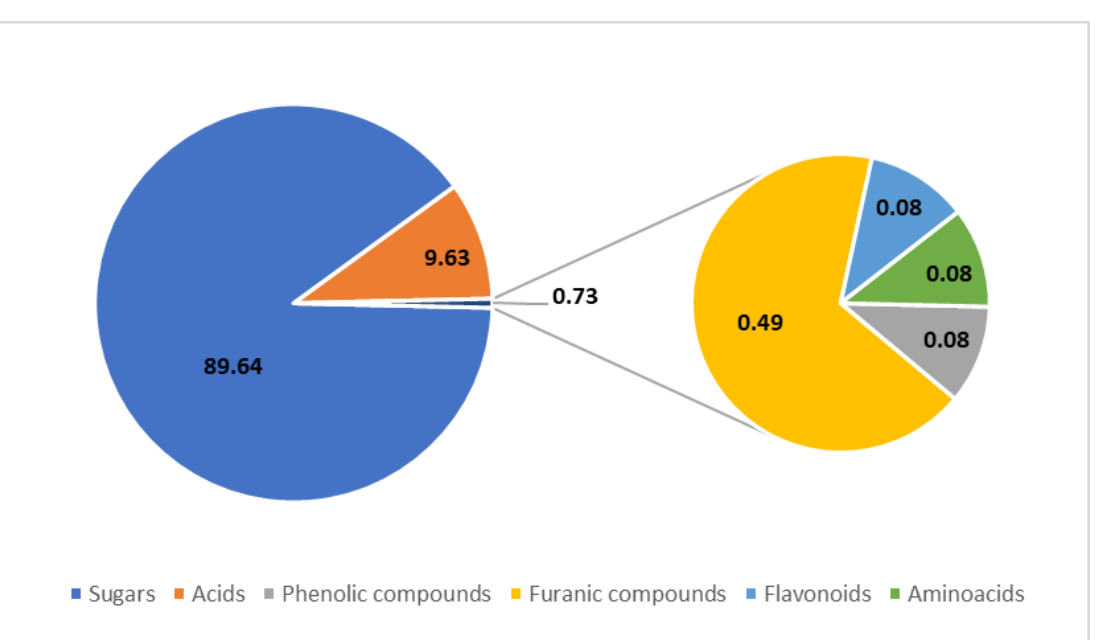
Figure 3. Profile of organic compounds in balsamic vinegars determined using HPLC, collected from several studies. The values are presented in % ( w / w ); based on data from [11–16]. Table 1. Table of methods used for GC analysis of balsamic vinegar samples.